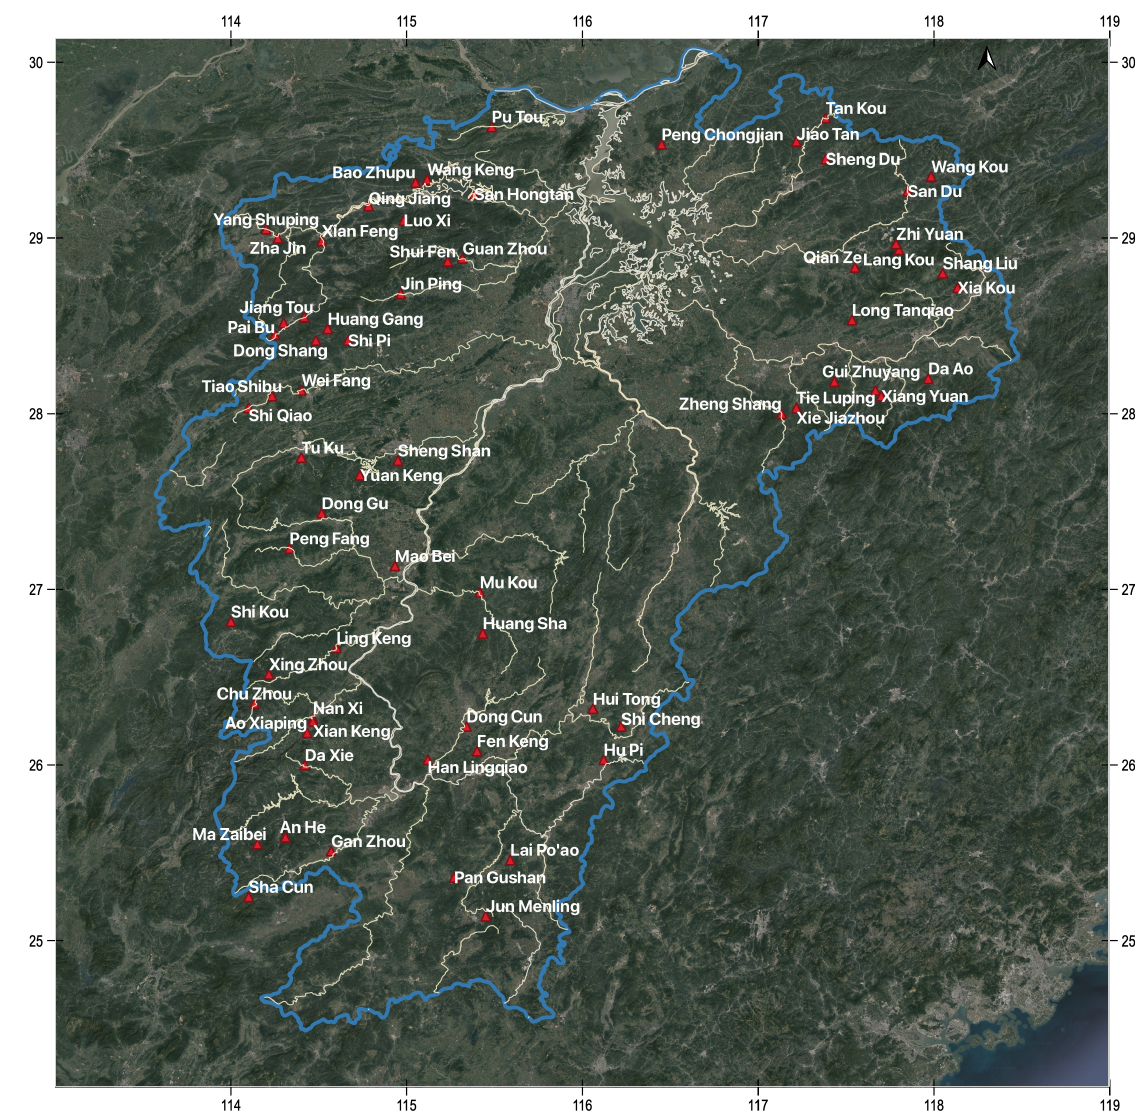
Figure 5. Distribution of 69 hydrological stations in Jiangxi Province.